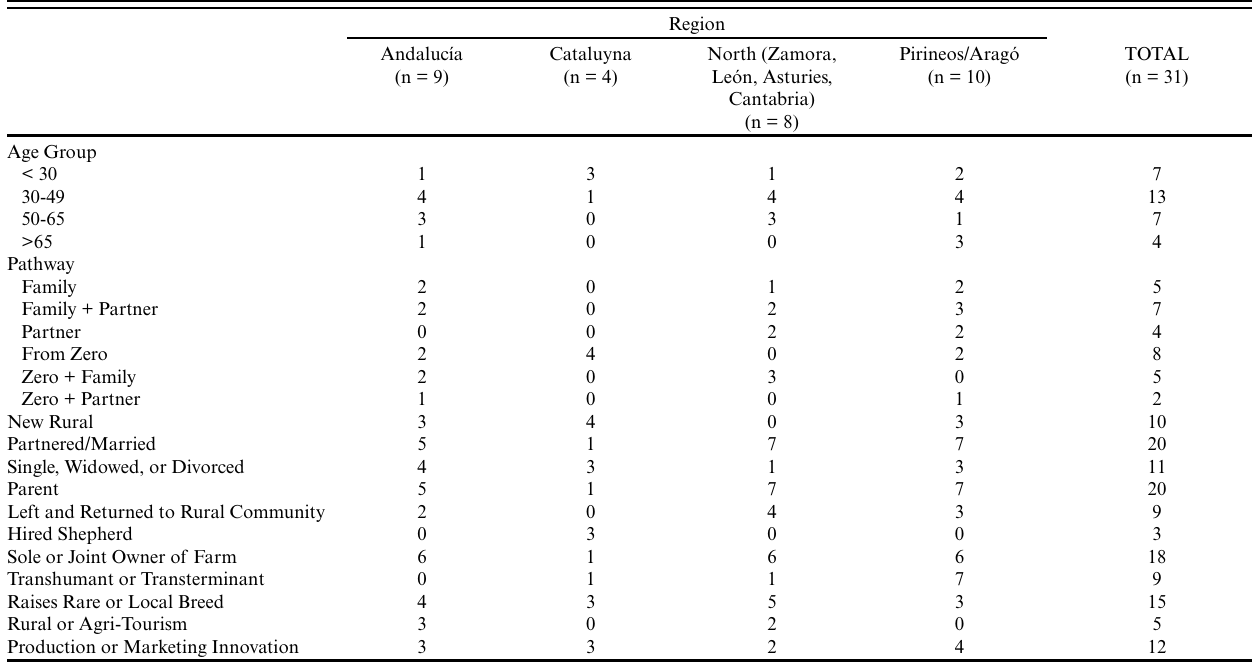
Table 1 . Characteristics of interview participants by